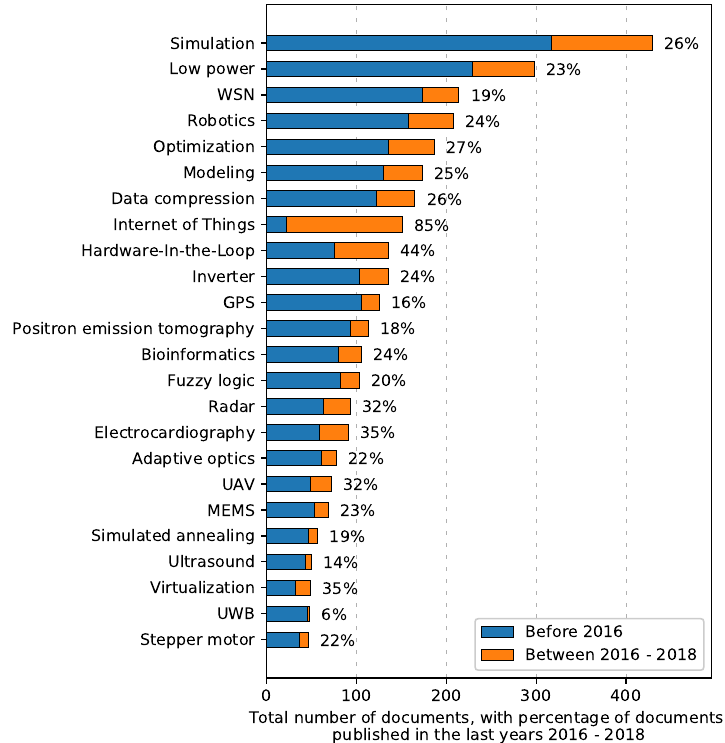
Figure 17. Other top applications in FPGA